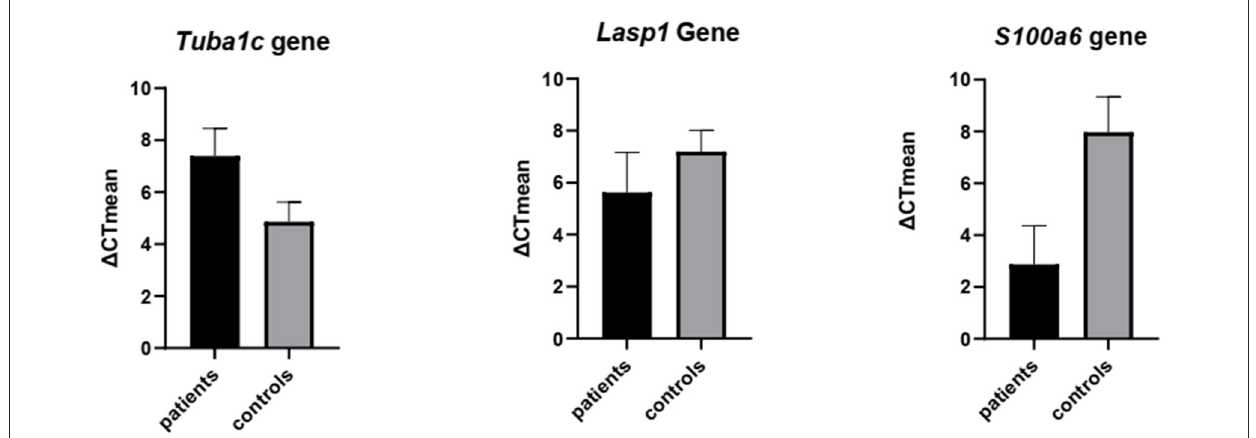
FIGURE6 Validation of the expression of TUBA1C , LASP1 , and S100A6 genes by real-time PCR. Unpaired t- test was used to detect differences in gene expression between 2 groups patients & controls using the Graph Pad Prism 8 software. Significance: P -value TUBA1C < 0.0001, P -value S100A6 < 0.0001, P -value LASP1 <